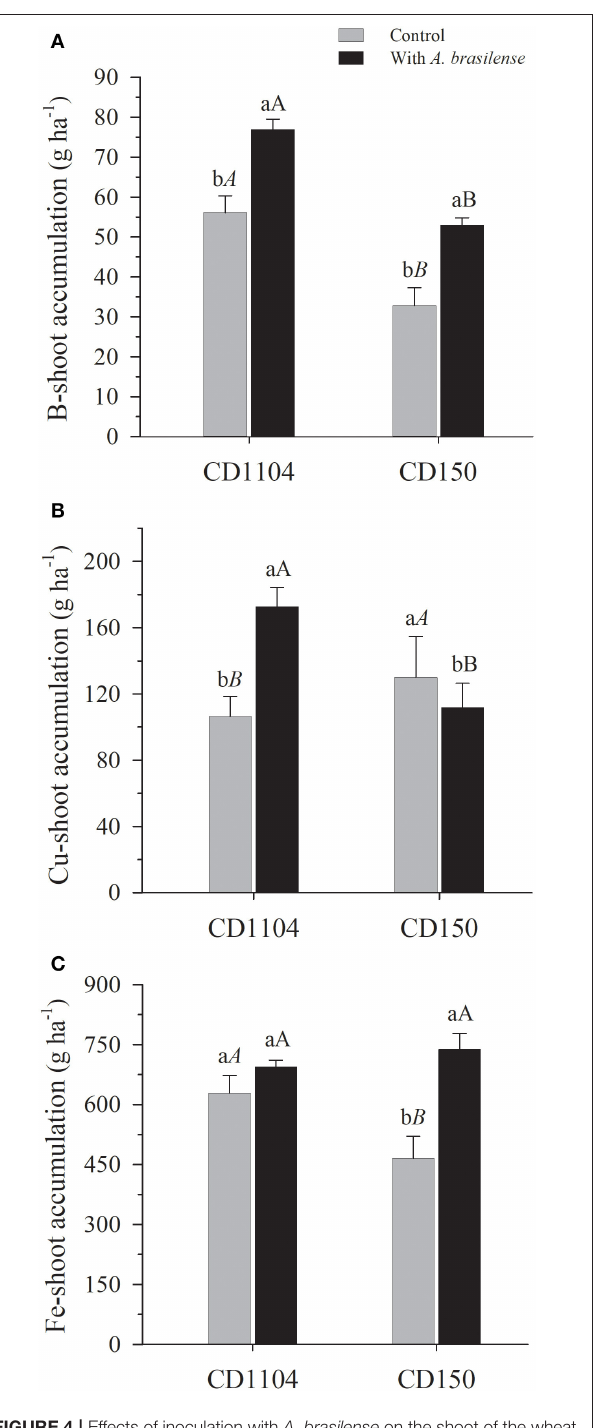
FIGURE 3 | Effects of inoculation with A. brasilense on the shoot of the wheat cultivars CD1104 and CD150 in the nutritional accumulation of Ca (A) , Mg (B) , and S (C) . Different letters indicate difference between means according to a Tukey test ( p ≤ 0.05). Lowercase letters correspond to cultivars within each inoculation level, and uppercase letters correspond to inoculations within each cultivar level. Identical letters do not differ from each other according to a Tukey test ( p ≤ 0.05). CV (%) = 20.1 (A) , 18.2 (B) , and 11.9 (C) . Error bars indicate the standard error of the mean ( n = 6 replications).